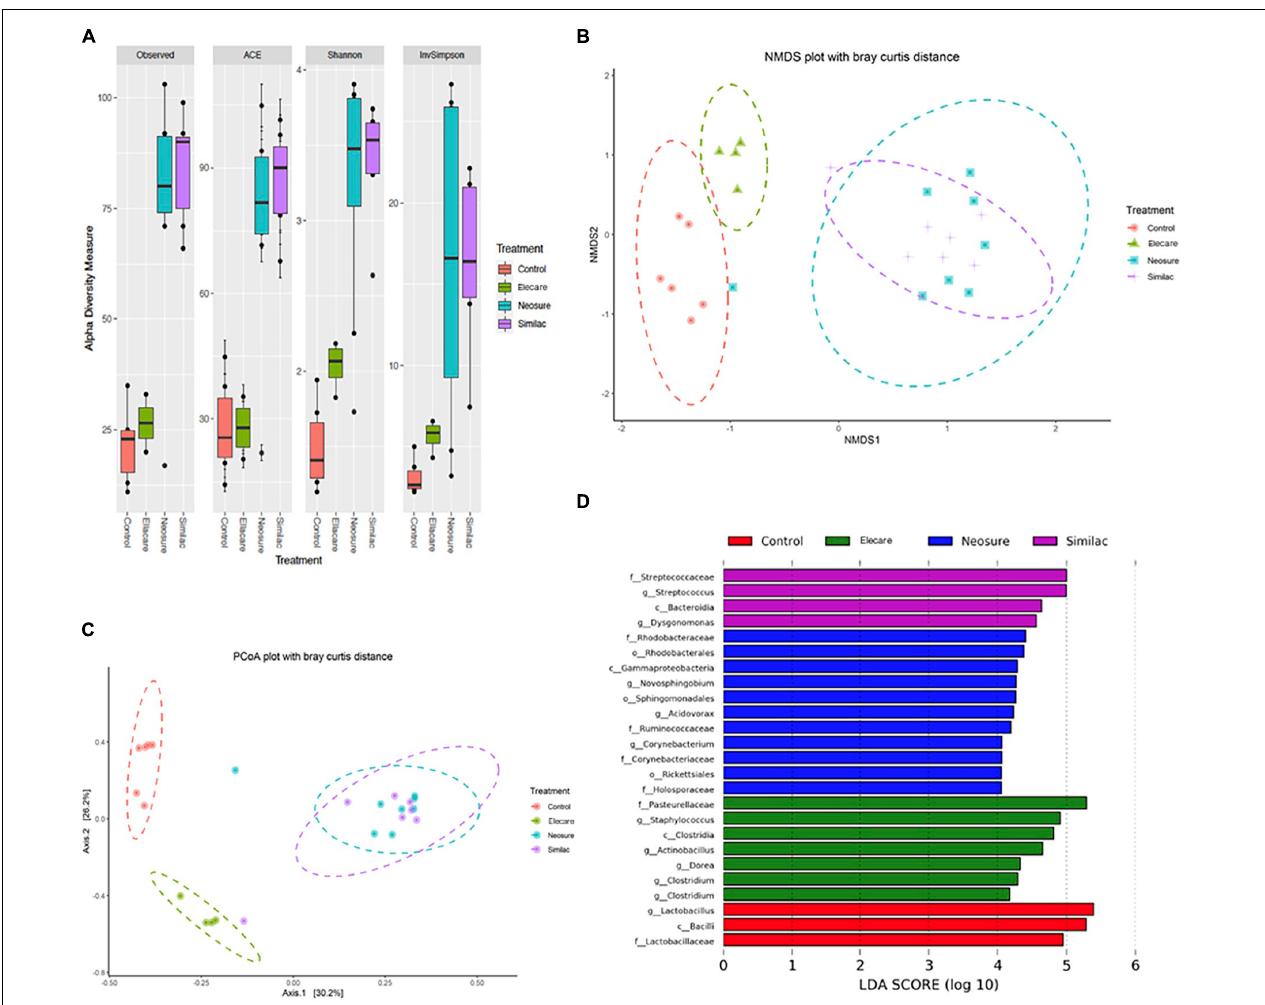
FIGURE 2 | Preterm formula influences the acquisition of the intestinal microbiome. (A) Alpha diversity calculations with Phyloseq software package. Standard diversity metrics were evaluated including observed richness, ACE, Shannon index, and InvSimpson. (B,C) Beta-diversity visualization with Non-metric Multi-dimensional Scaling (NMDS) and Principal Coordinate Analysis (PCoA) plots based on Bray-Curtis distances. (D) The linear discriminant analysis (LDA) value distribution histogram. Taxa meeting a linear discriminant analysis significant threshold > 4 are shown. c: class level; f: family level; g: genus level; o: order level; p: phylum